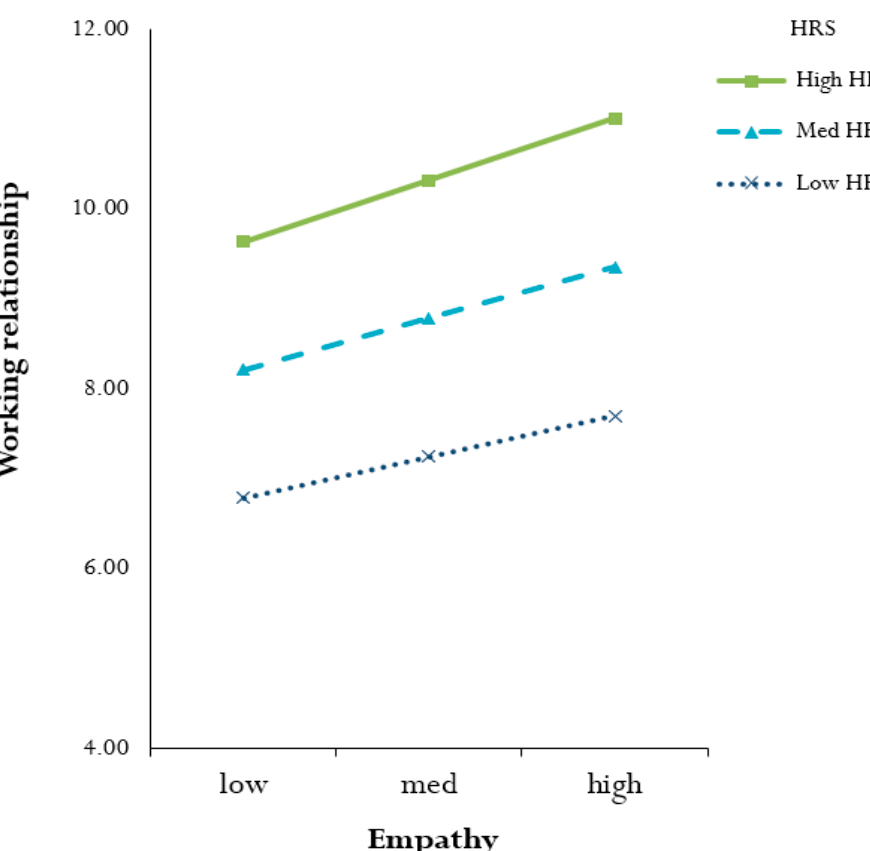
Figure 1. Simple slopes for the moderating effect of HRS on the relationship between empathy and WR (high HRS: slope = 2.16, t = 3.807, p < 0.001; med HRS: slope = 1.80, t = 4.003, p < 0.001; low HRS: slope = 1.44, t = 4.309, p < 0.001).